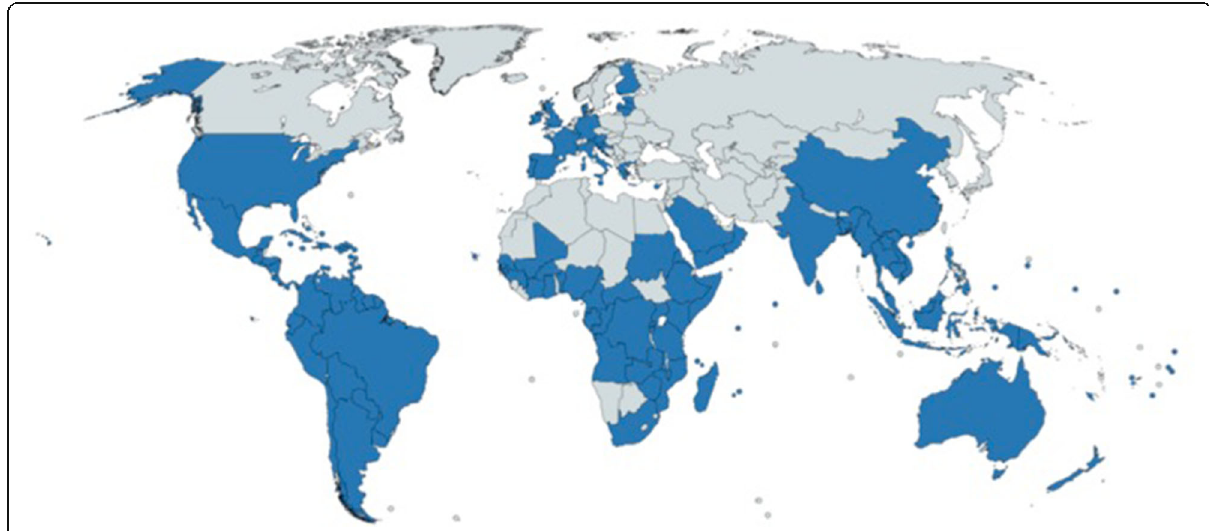
Fig. 1 Distribution of Aedes mosquitos (created with mapchart.net